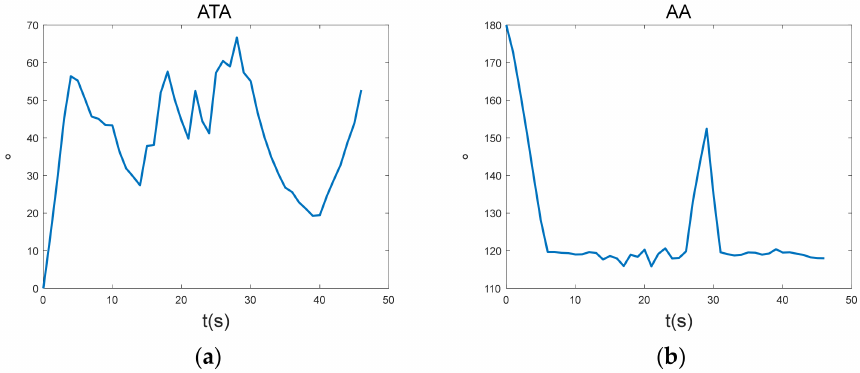
Figure 19. ATA and AA change curves. ( a ) UCAV; ( b ) enemy.